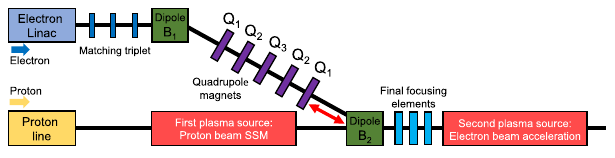
FIG. 1. Schematic view of an electron-beam transfer line with two plasma sources (not to scale). Note that the transfer line in this schematic view is not the AWAKE baseline design but a simplified generic variation to study CSR